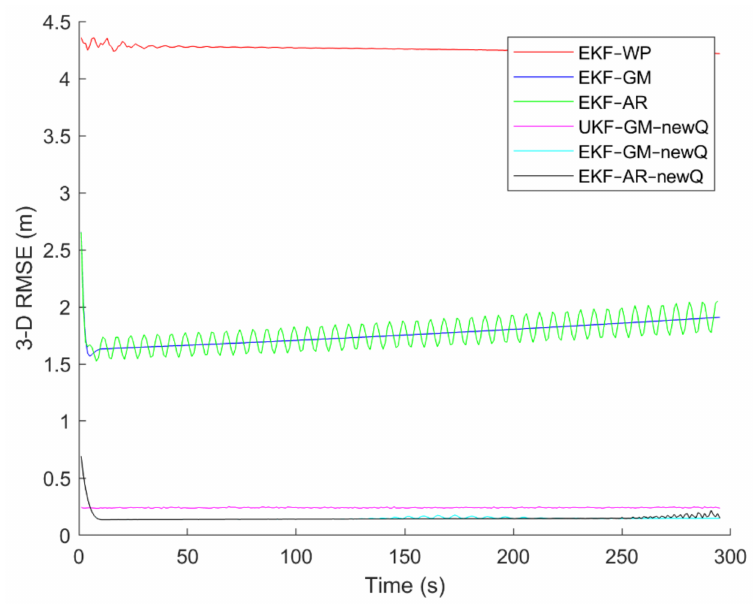
Figure 17. The positioning error of different methods in the second